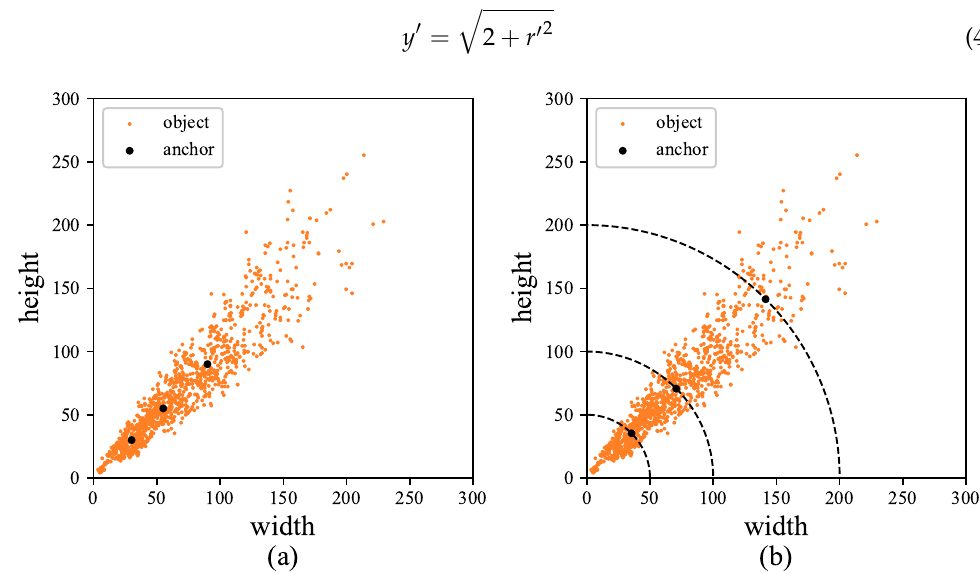
Figure 2. ( a ) In the general algorithm, all anchors are obtained through all objects. ( b ) In the Layered Anchor Generation (LAG), anchors of each layer are obtained by analyzing objects within the range of the layer.